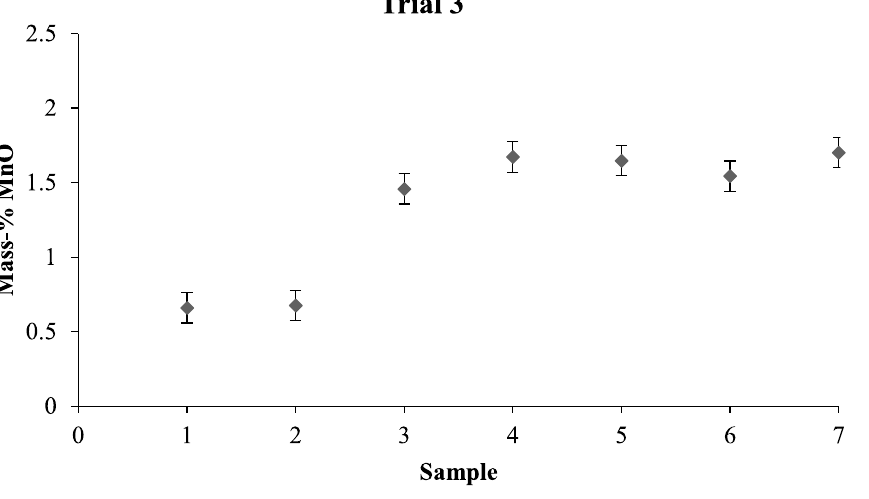
Figure 3. Content of MnO (%) for all the samples taken during Trial 3, where samples 1 and 2 were taken before tracer addition and the rest of the samples were taken after the addition of the MnO 2 tracer powder.